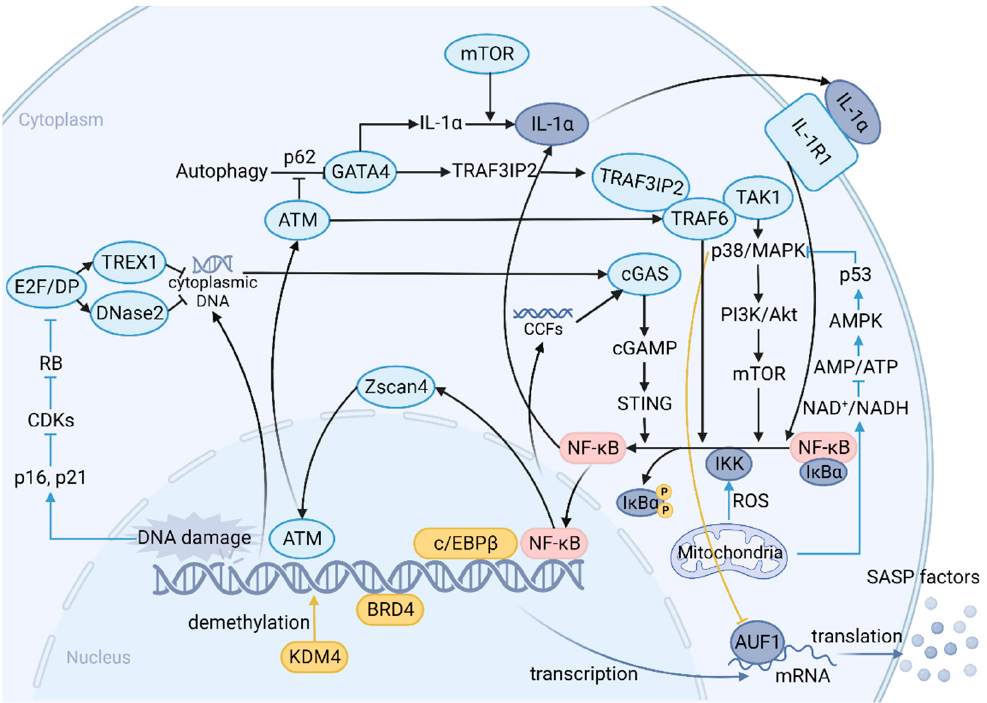
Figure 2. Mechanisms involved in senescence-associated secretion phenotype (SASP) regulation. (Created with BioRender.com).